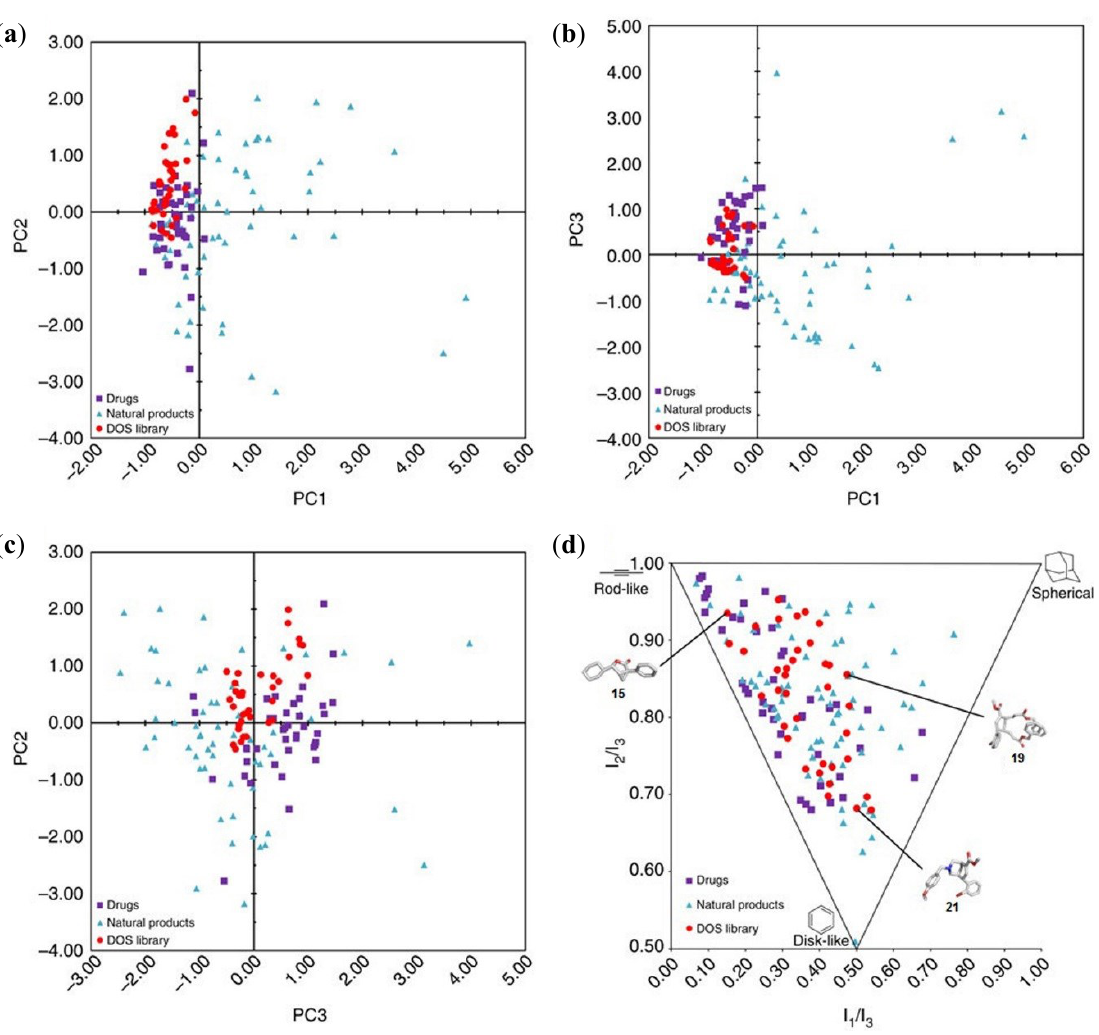
Figure 4. ( a – c ) Comparative PCA plots of DOS library compounds (red, circles) vs . top-selling brand-name drugs (purple, squares) and natural products (blue, triangles); ( d ) PMI plot illustrating the molecular shape diversity of the DOS library (red, circles) and lowest-energy conformation of three representative DOS library members ( 15 , 19 , 21 ). Adapted by permission from Macmillan Publishers Ltd: ref. 53, copyright